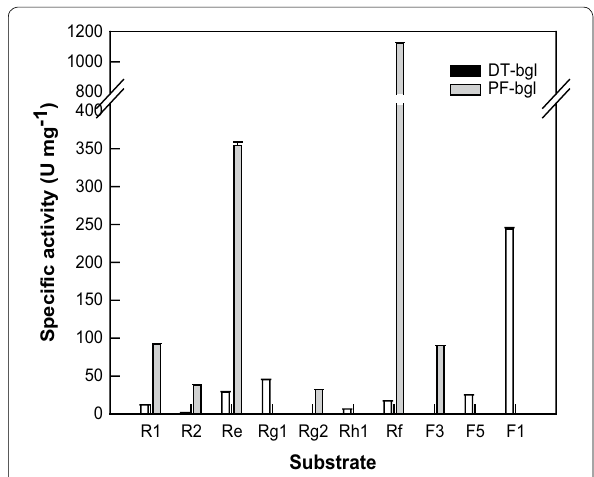
Fig. 1 Specific activities of DT‑bgl and PF‑bgl for all typical PPT ginse‑ nosides. Black and gray bar represent DT‑bgl and PF‑bgl, respectively